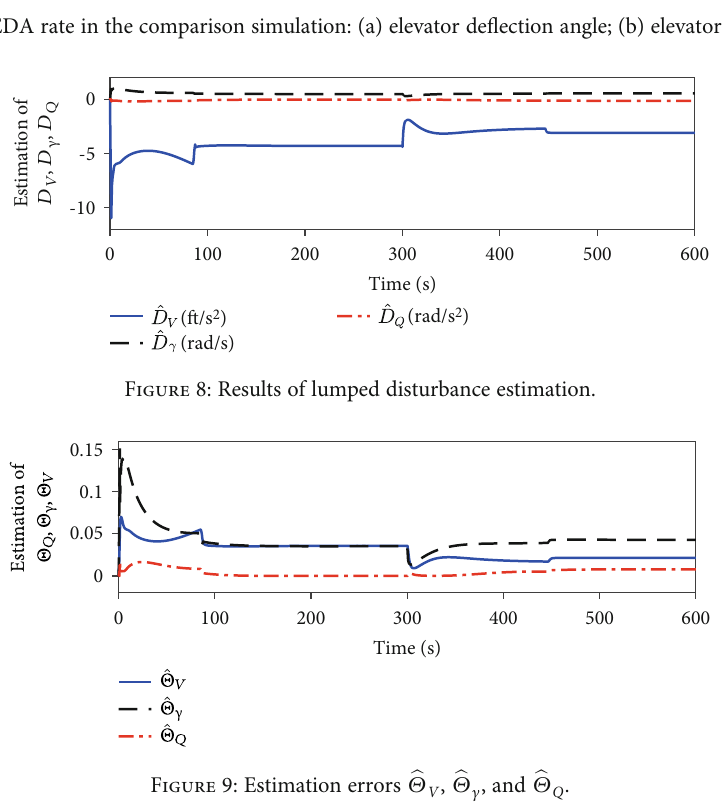
Figure 9: Estimation errors b Θ